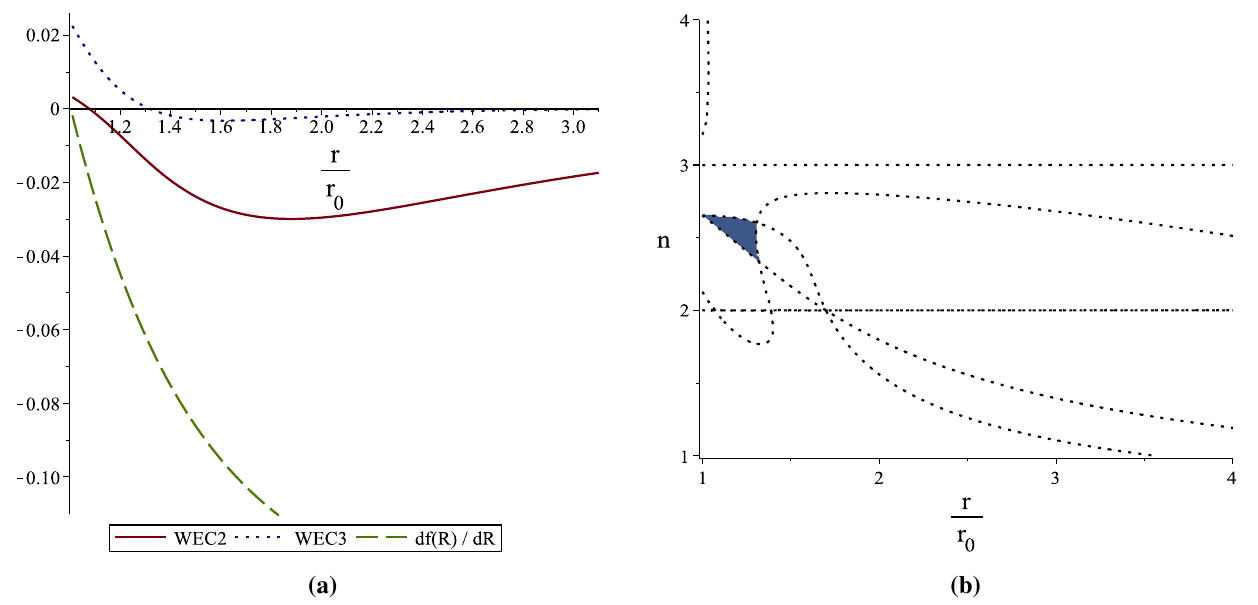
Fig. 7 Setting n = 2 . 65 in a we found a wormhole solution in the exponential gravity model that respect NEC. The blue region in b also shows that it is possible to find wormholes solutions in this model that respect NEC around the throat. In these figures we set λ = 2 , R ∗ = 0 . 01 and r 0 =